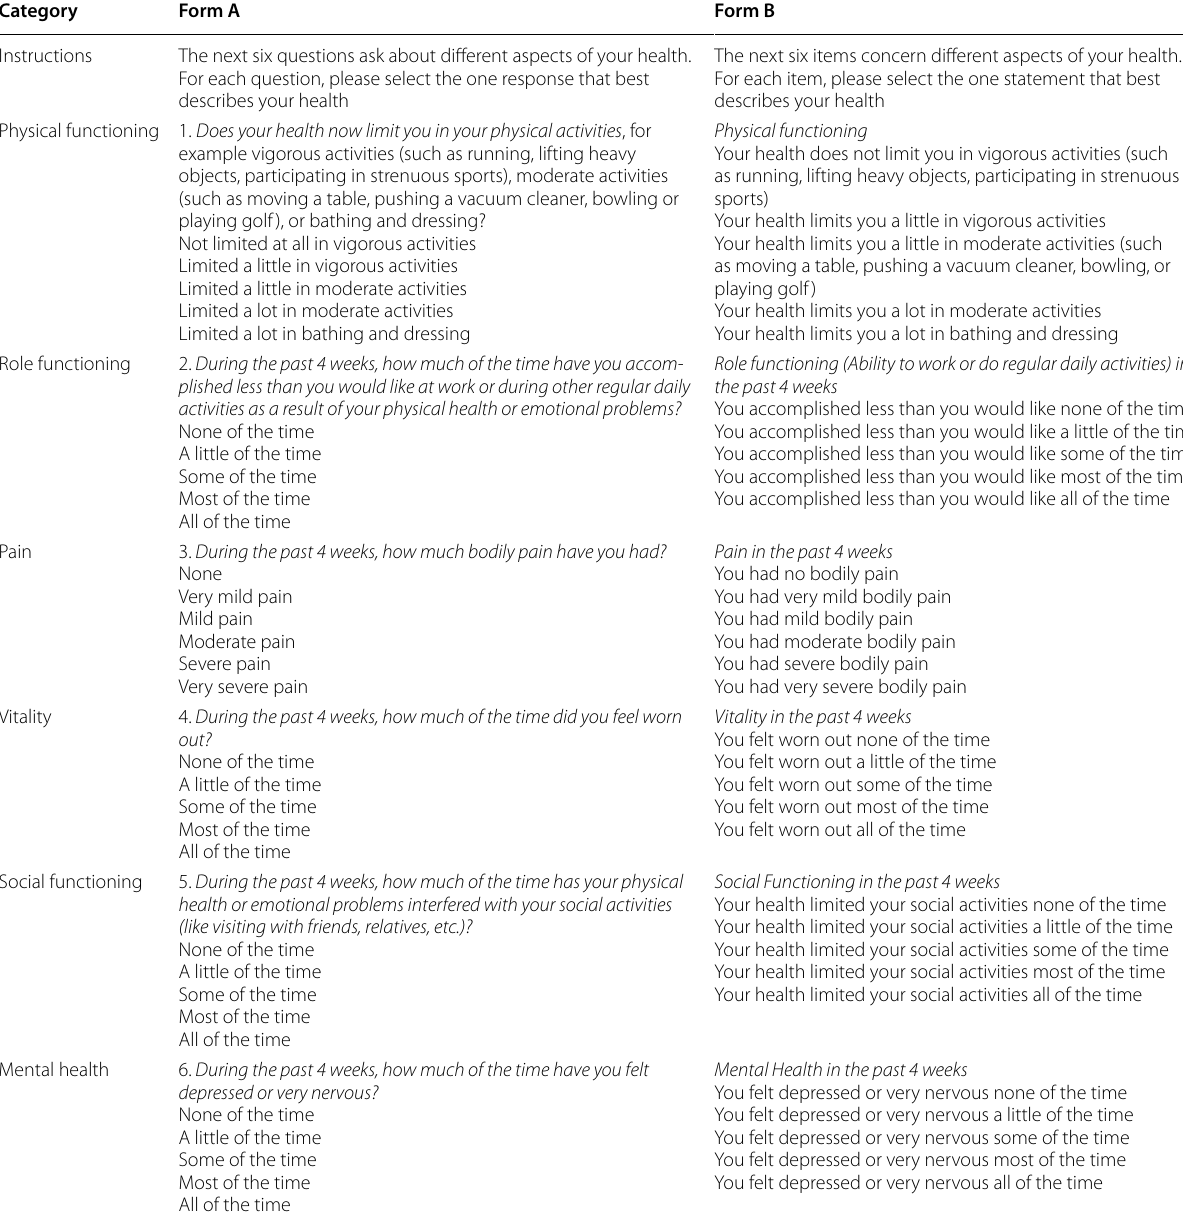
Table 1 Overview of SF‑6Dv2 Forms A and B Category Form A Form B